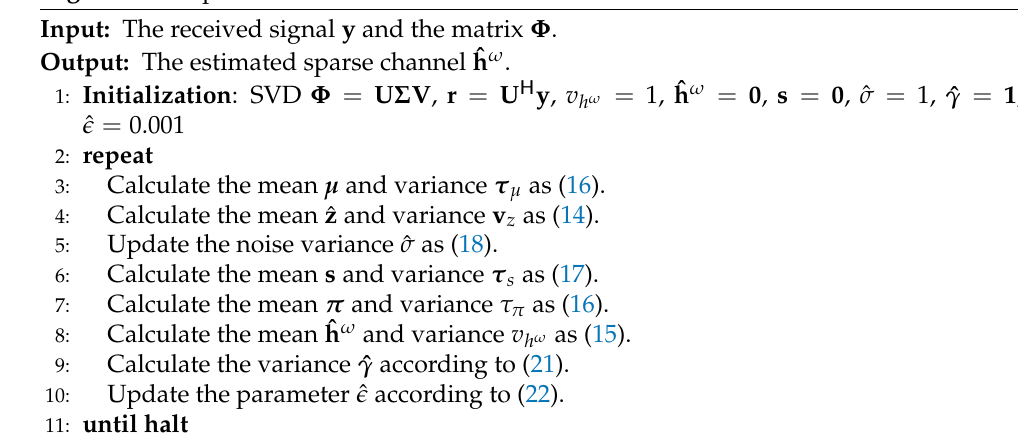
Algorithm 1 Uplink channel estimation with